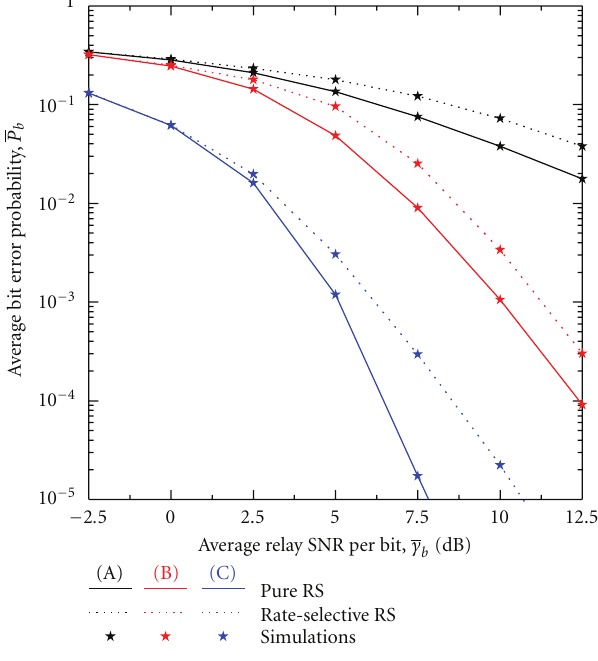
Figure 8: ABEP, P b , of DBPSK for RS versus the average relay SNR = 0dB over INID Nakagami- m fading chan- per bit, γ , and for γ 0 b nels: (A) L = 1, m 0 = 0 . 5, m 1 = 1, and δ = 0 . 1, (B) L = 2, m 0 = 1, m 1 = m 2 = 2, and δ = 0, and (C) L = 3, m (cid:5) = 3 for (cid:5) = 0,1,2, and 3 and δ =